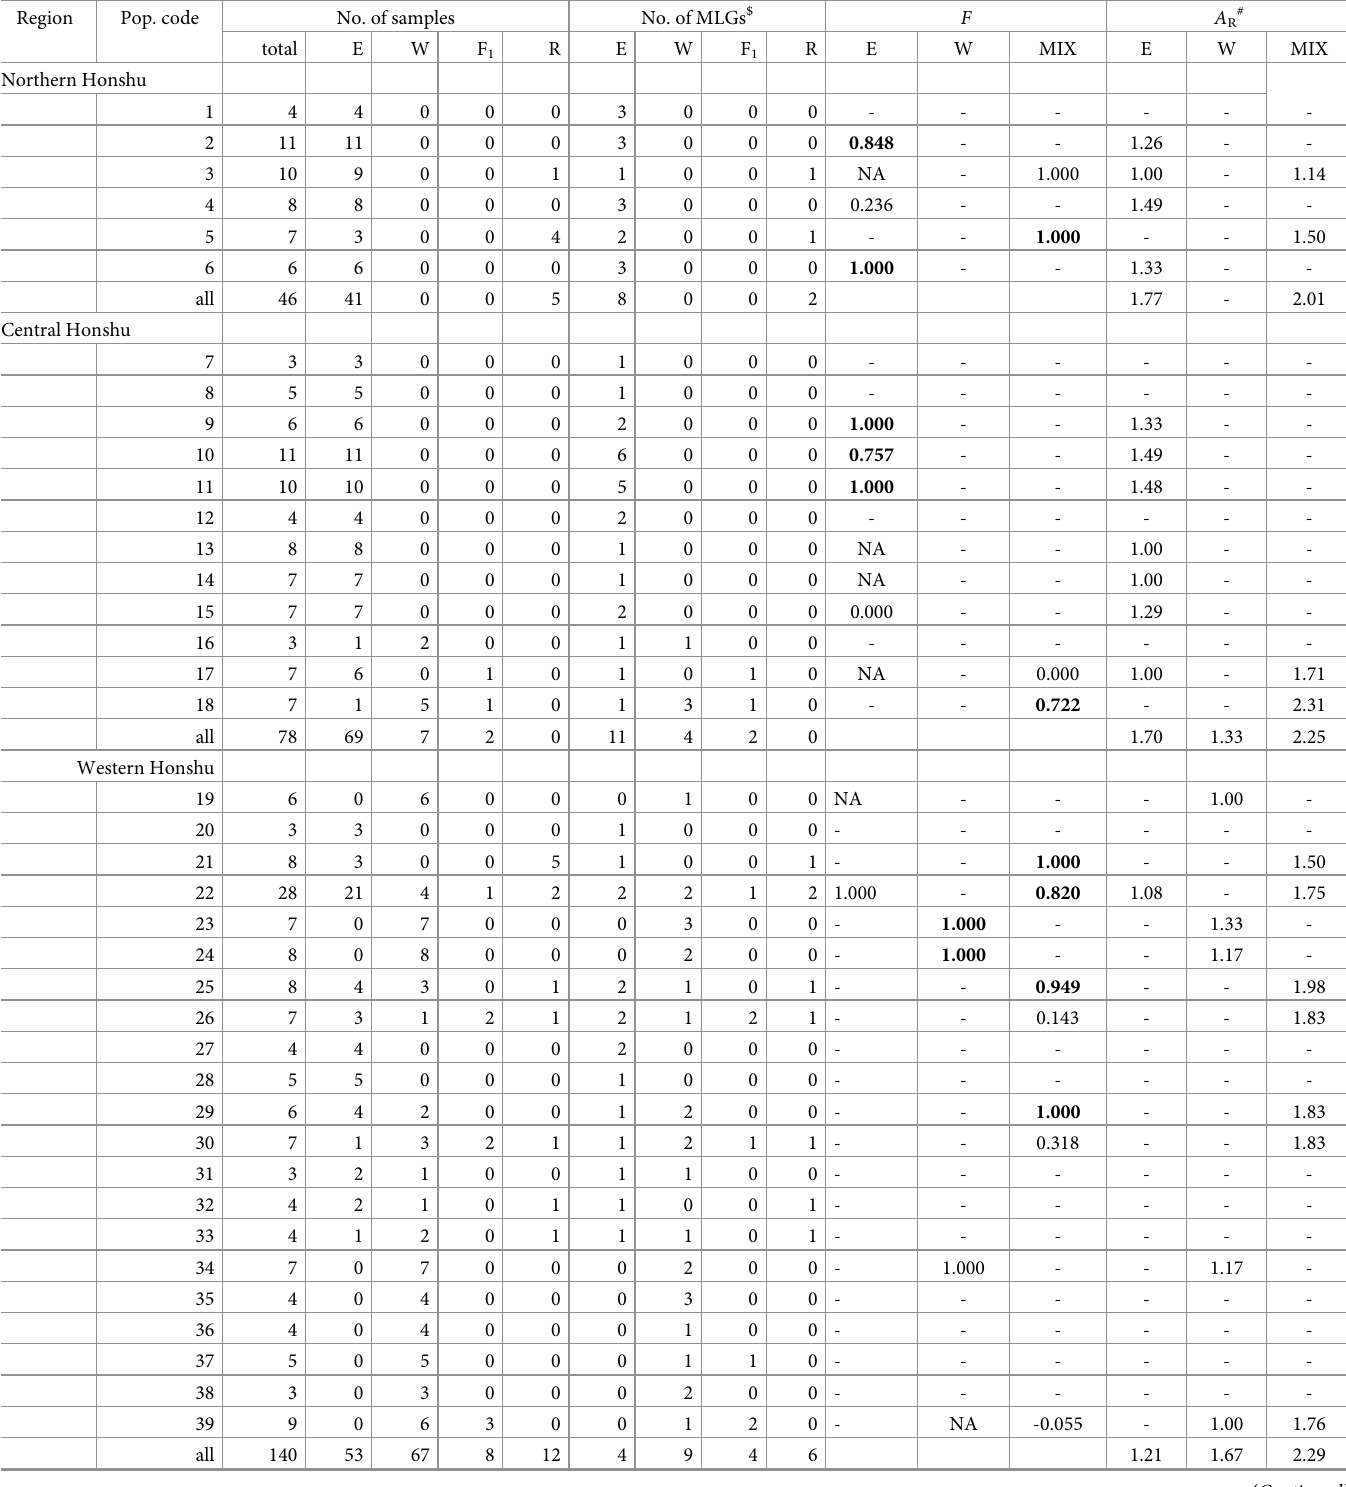
Table 1. Numbers of East- and West-type individuals, inbreeding coefficients ( F ), and allelic richness ( A r) in the Lepisorus nigripes populations. Region Pop. code No. of samples